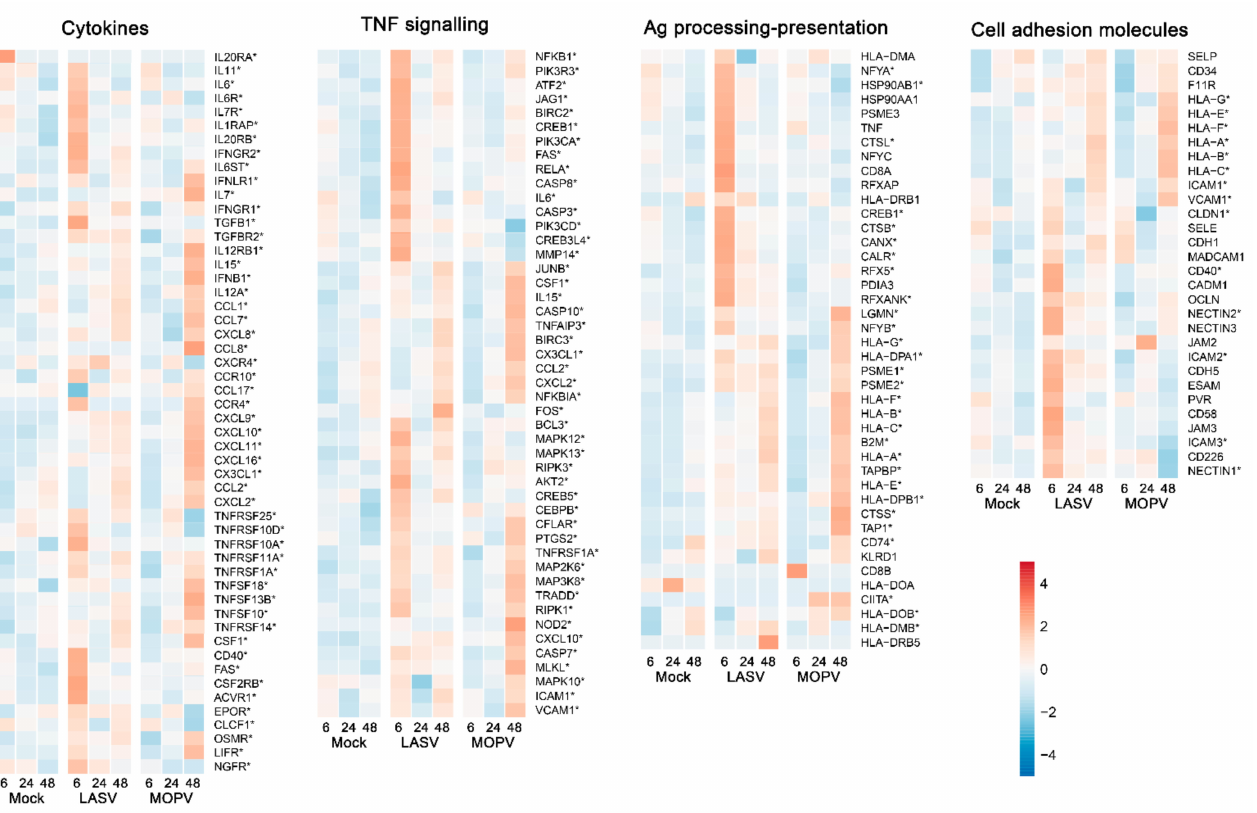
Figure 4. Heatmaps of the gene expression profiles of gene sets related to cytokines, TNF signaling, antigen processing/presentation, and cell adhesion molecules. Results are shown as in Figure 3. Genes that are DE in any of the pairwise comparisons are highlighted with